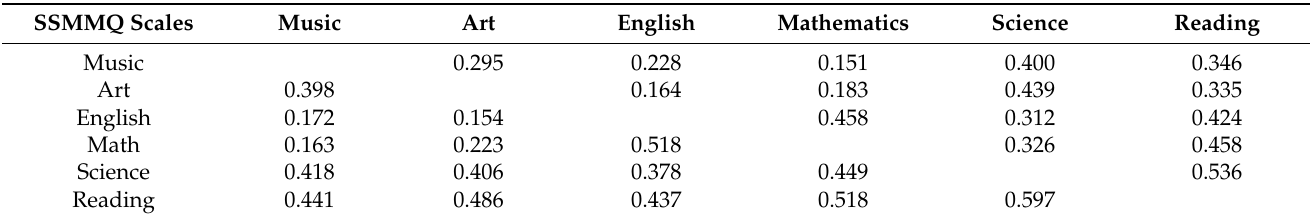
Table 4. HTMT ratio of correlations among the SSMMQ factors of the Romanian and Russian versions.